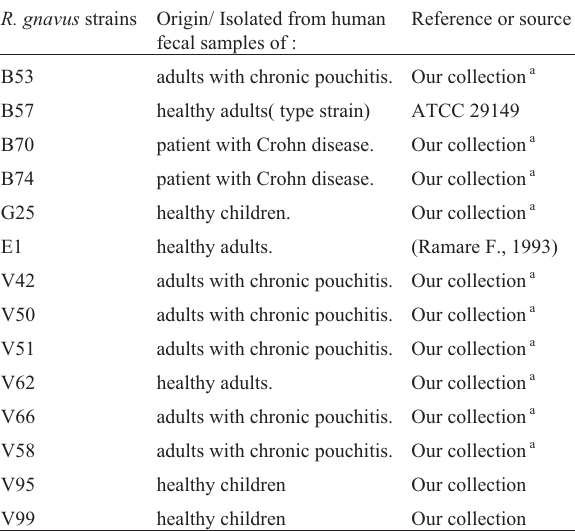
Table 1 - Strains of Ruminococcus gnavus . R. gnavus strains Origin/ Isolated from human fecal samples of :